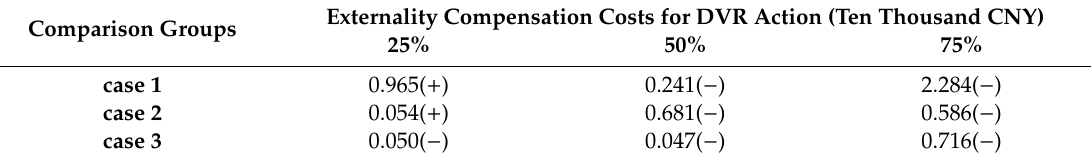
Table 4. Comparison of external cost caused by DVR action within one